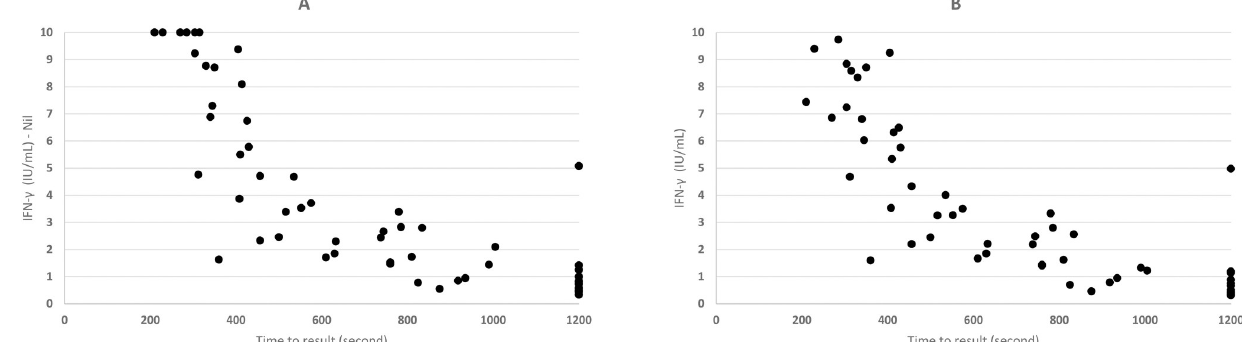
Fig 1. Distribution plot of IFN- γ values (uncorrected and corrected TB2 values) versus TTR for positive samples (n = 55). A- uncorrected values. B– corrected values.